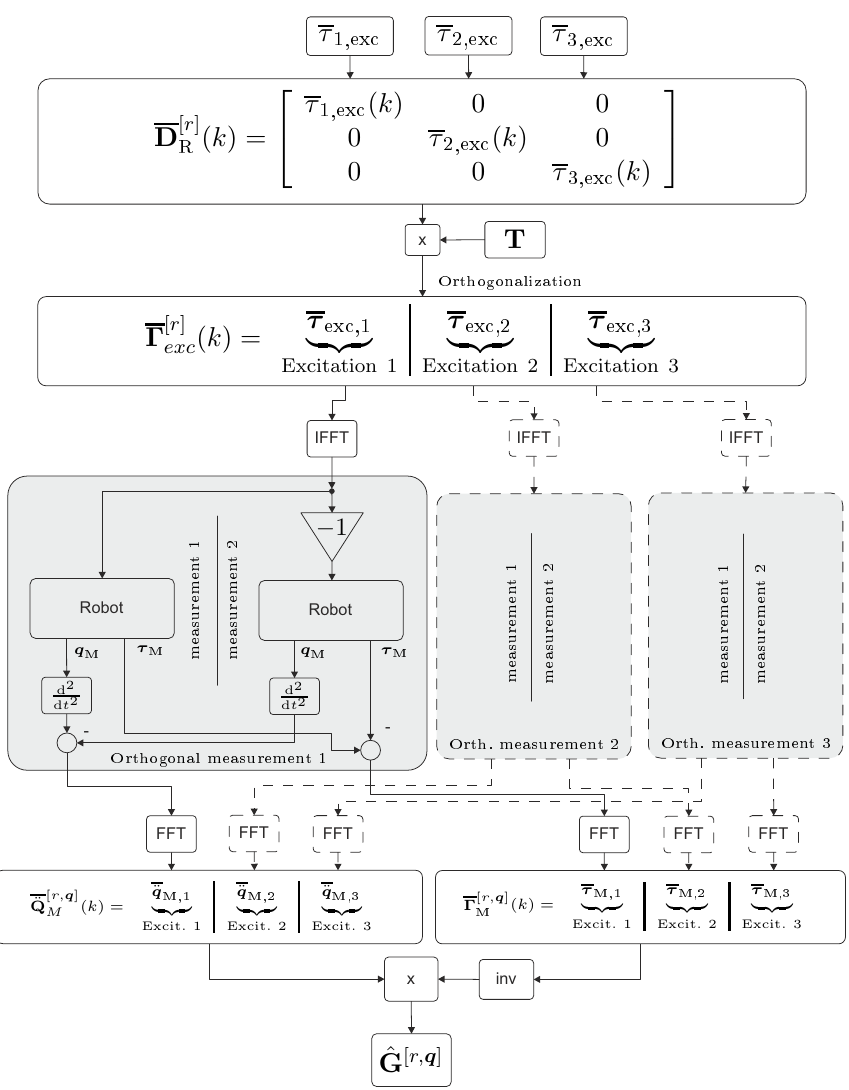
Figure 4. Measurement schedule for the FRM calculation of one realization.